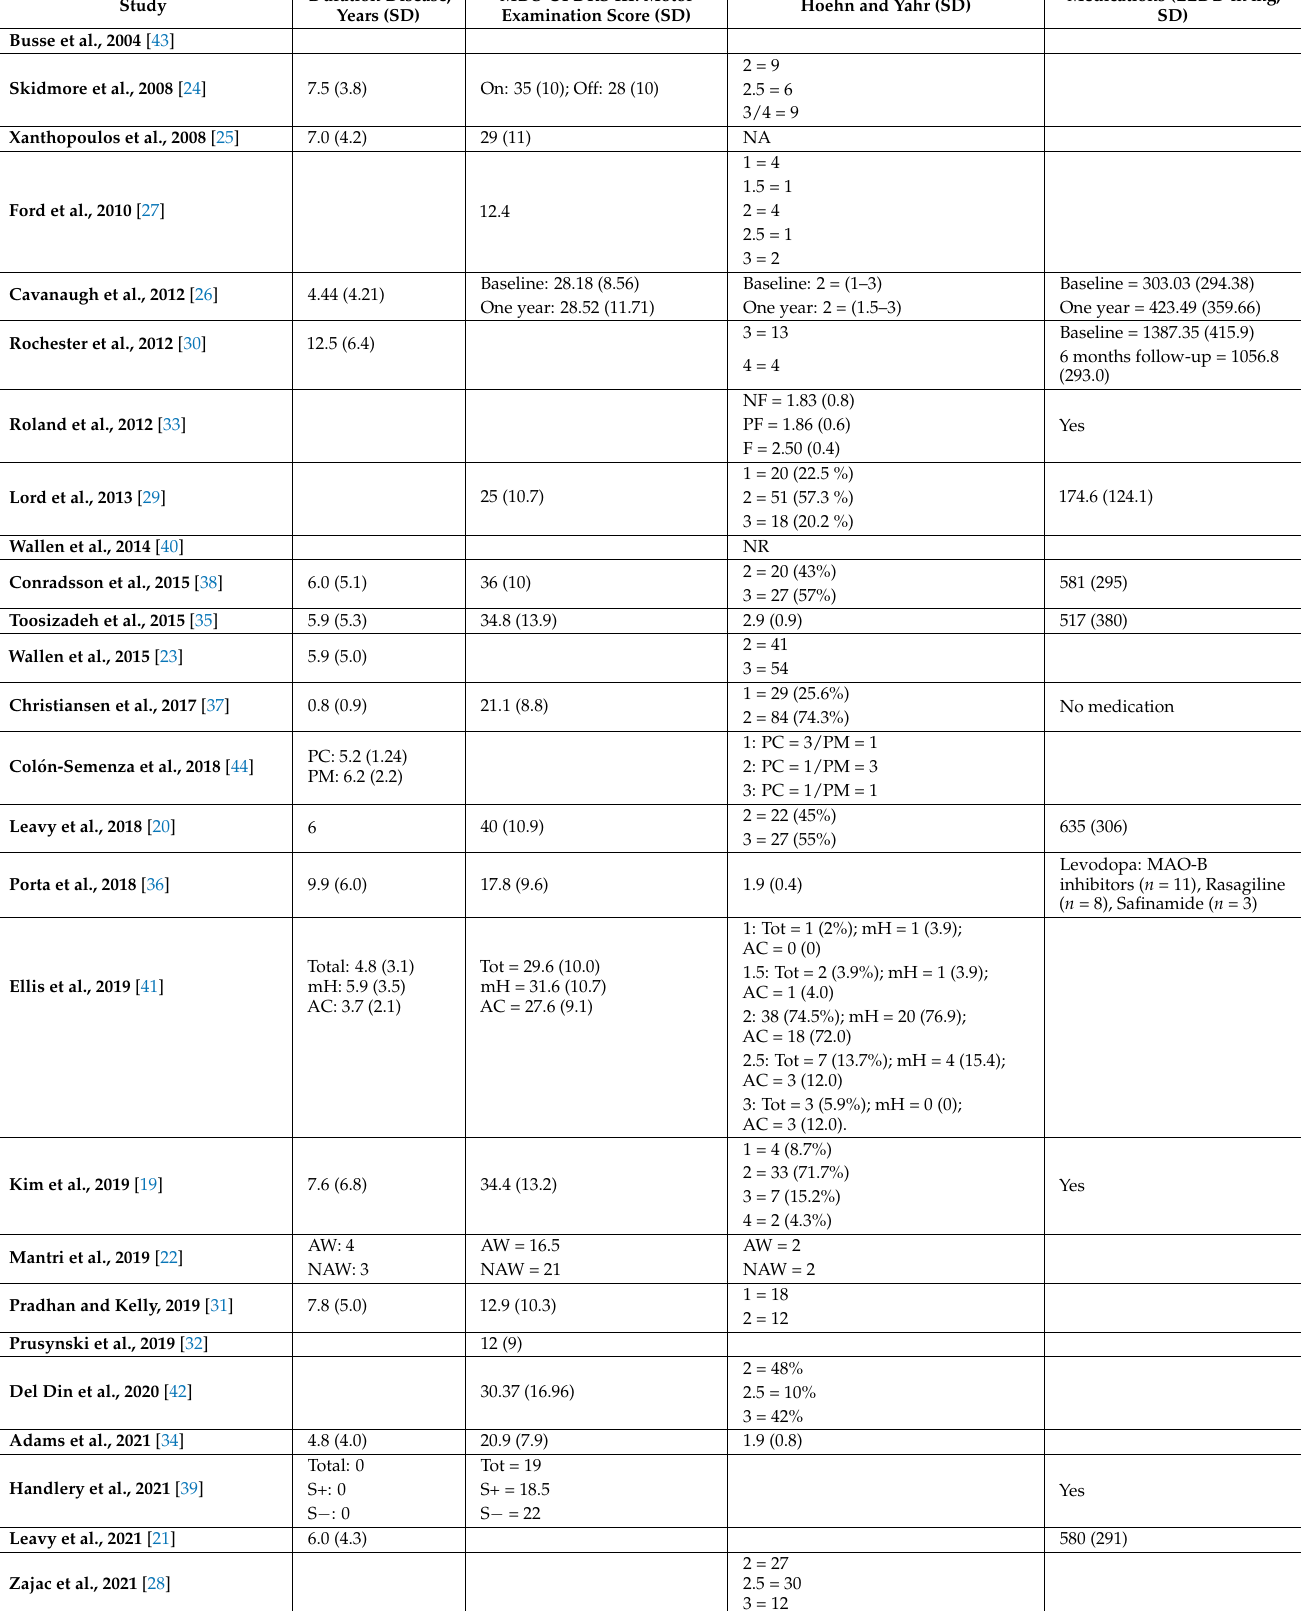
Table A2. Characteristics of patients concerning cognitive